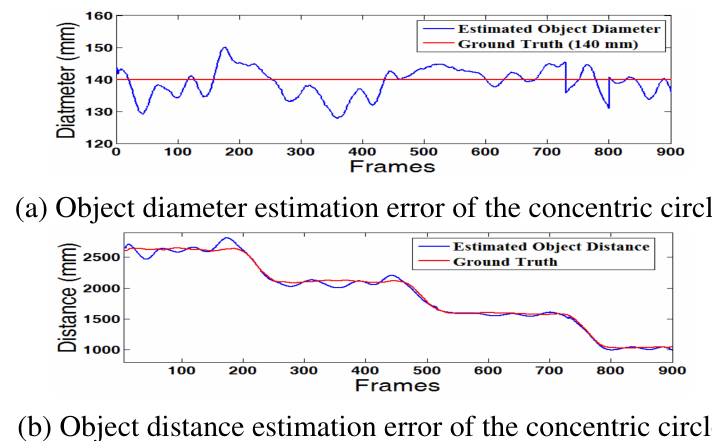
Figure 9. 3D trajectory of the moving object (red, with Kalman filtering; blue, without Kalman filtering).